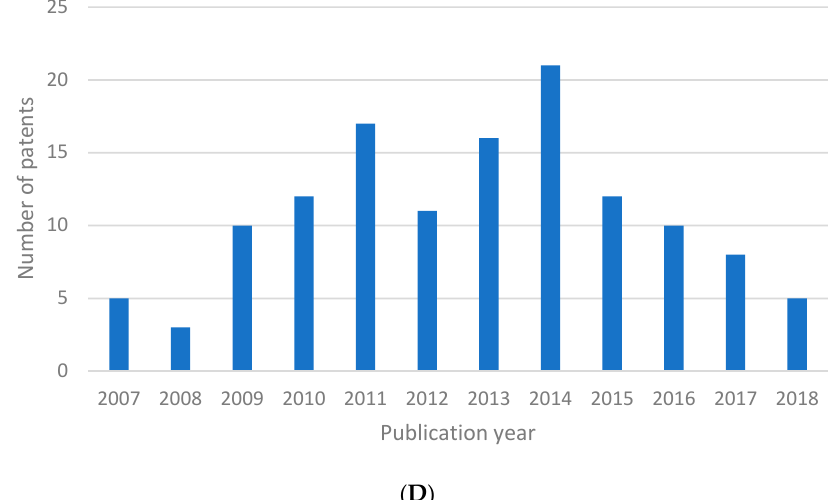
Figure 7. Number of parabolic trough patents vs publication year ( A ); Number of linear Fresnel reflector patents vs publication year ( B ); Number of solar tower patents vs publication year ( C ); Number of parabolic dish patents vs publication year ( D ).